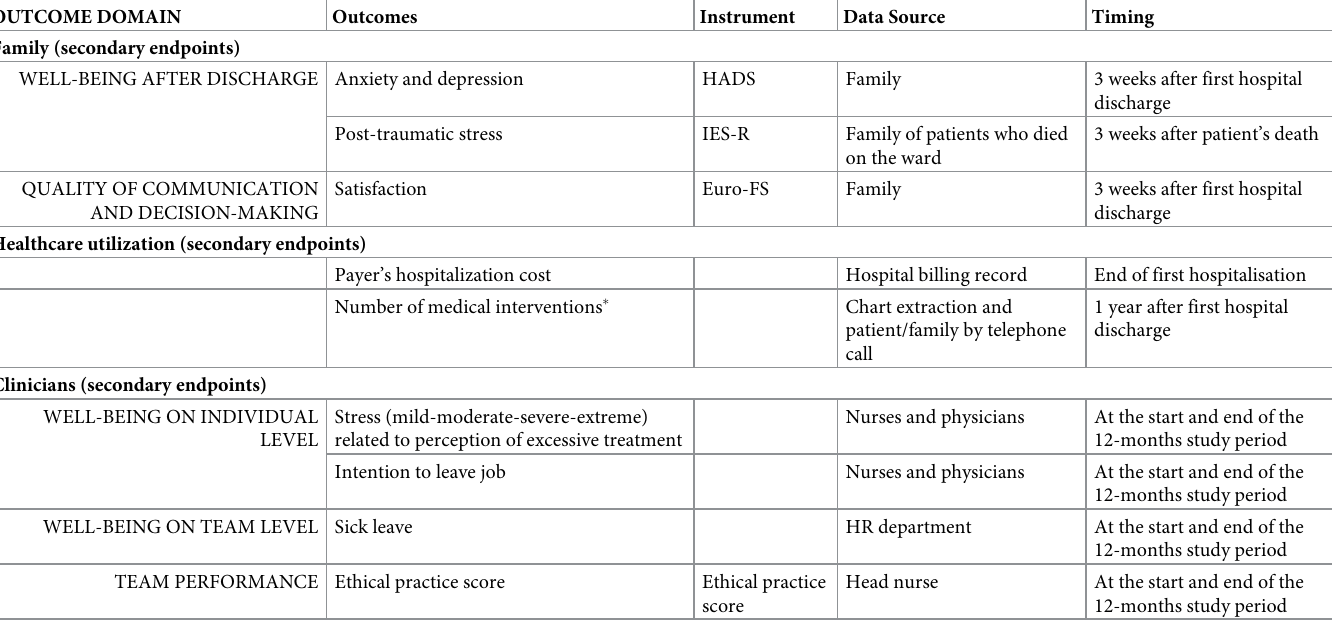
Table 3. Overview of collected data and timelines: Secondary outcomes on family, clinician and societal level. OUTCOME